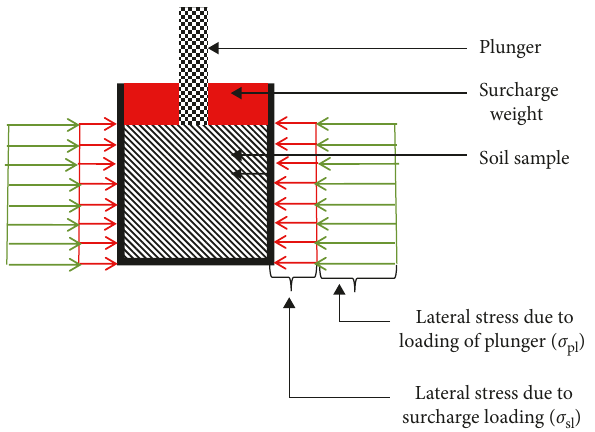
Figure 5: An assumed configuration of axial and lateral stresses during CBR